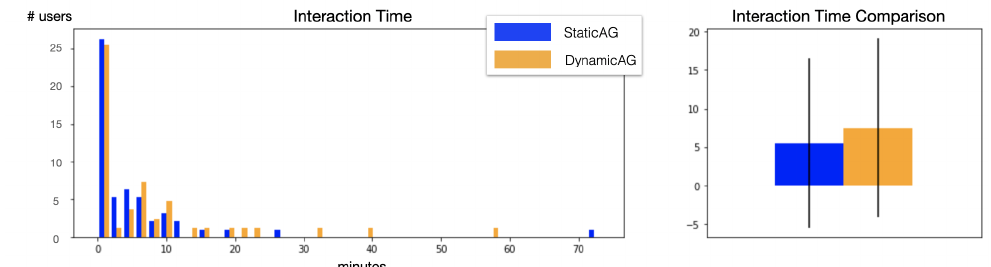
Figure 9. Comparison of Interaction Time. Left side: histogram. Right side: the average time students interacted with gamification elements and the variance of all students in each group. “# users” means number of